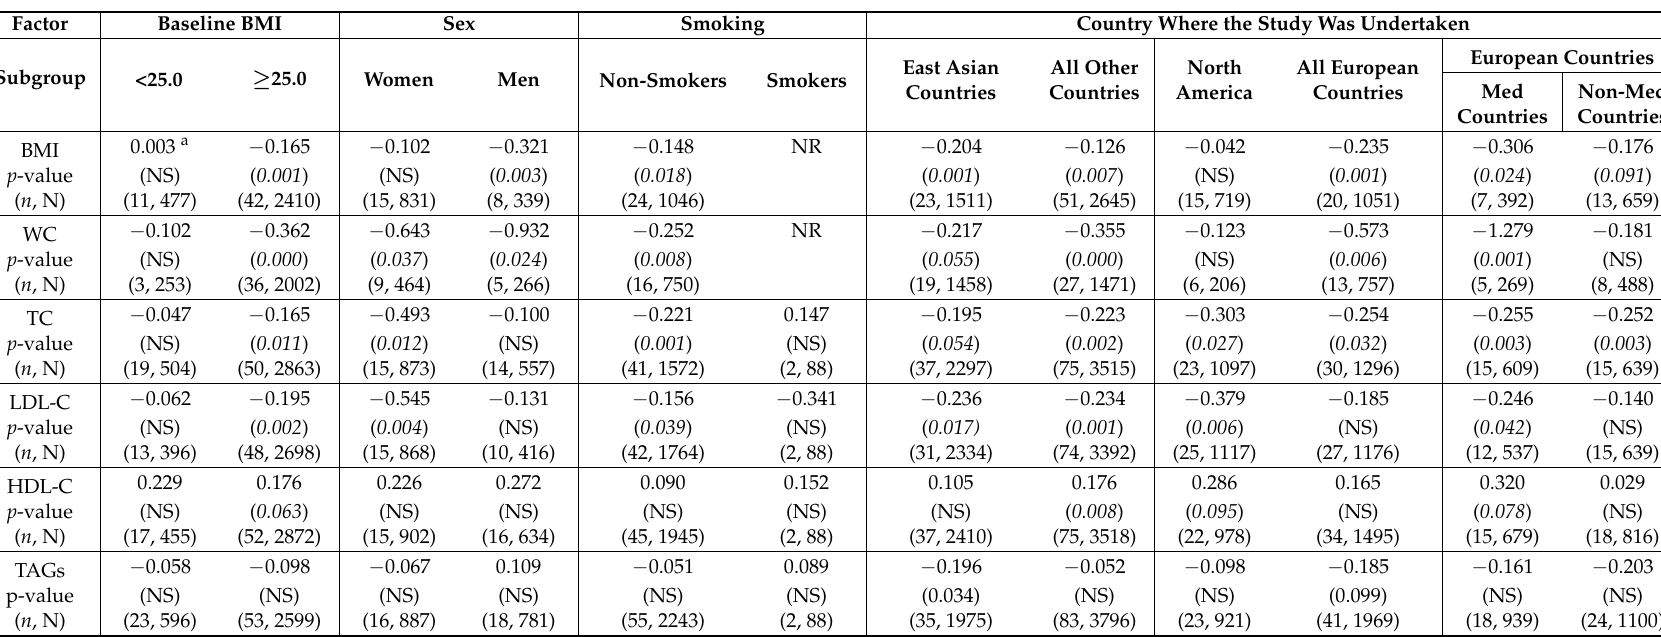
Table 3. Stratification analysis of the influence of baseline BMI, sex, smoking and country where the study was carried out on the effects (SDM) on BMI, WC, and blood lipids levels following supplementation with flavanol-containing